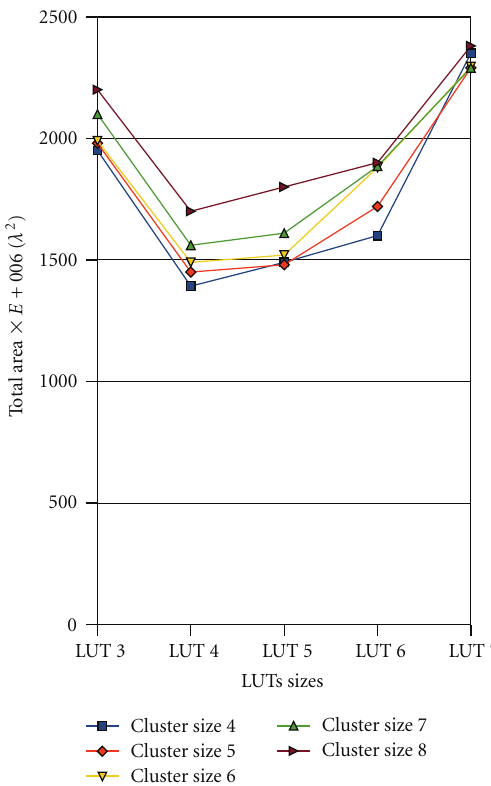
Figure 7: Total area for clusters sizes 4–8 (21 benchmark average).